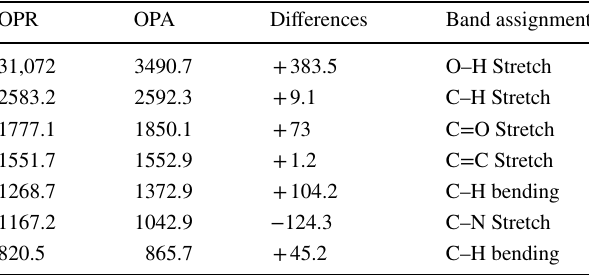
Table 2 FTIR spectra of raw and acid-activated orange peel (OP) wavenumber (cm-1)